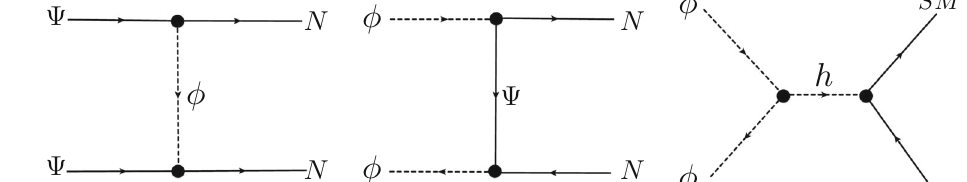
Fig. 4 Relevant annihilation channels Fig. 5 Allowed parameter space of the mediator mass and coupling in the scalar ( left ) and fermion Dark Matter ( right )